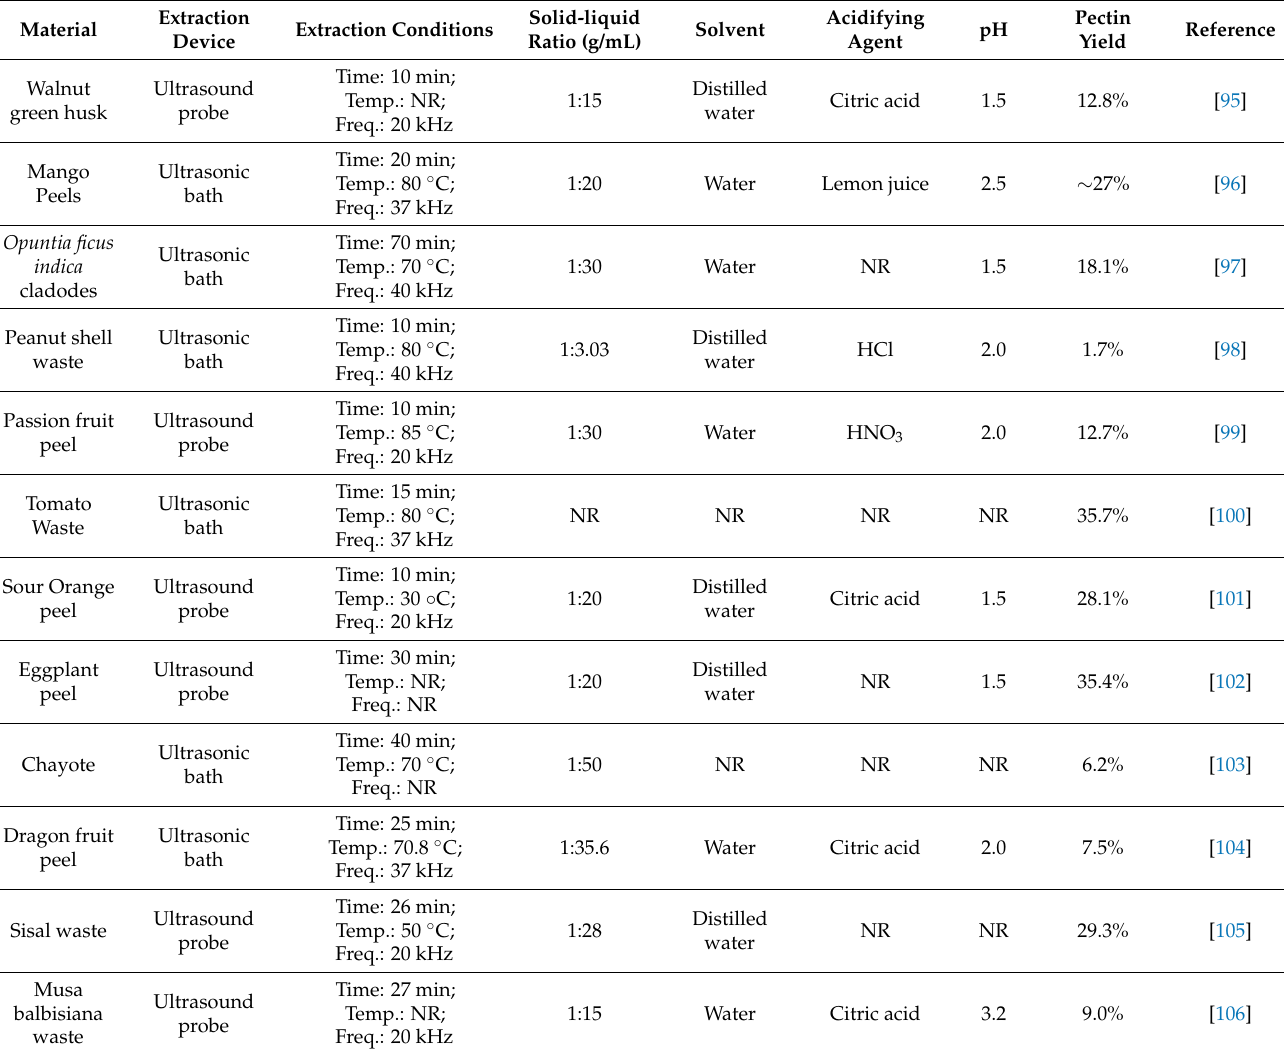
Table 4. Extraction of pectin by ultrasonic-assisted